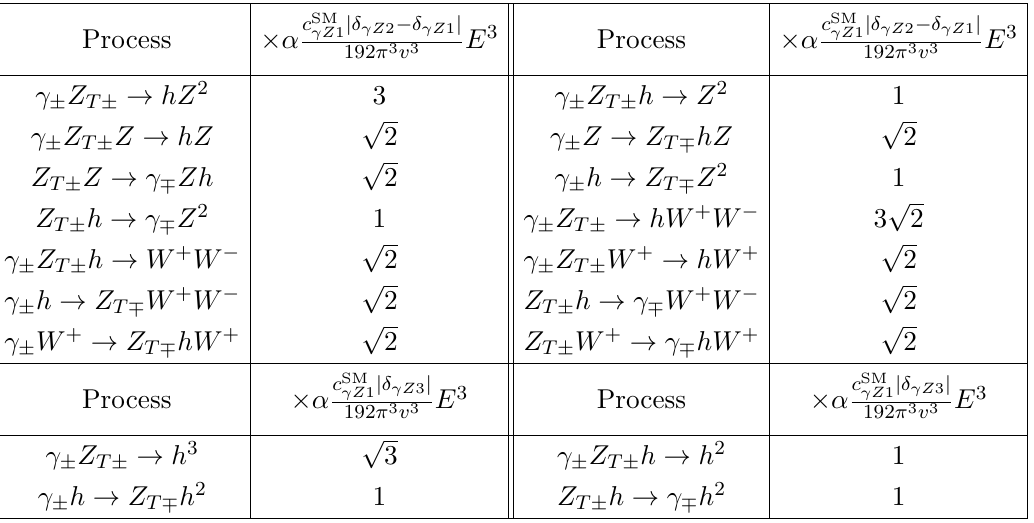
Table 6 . | ˆ M | of the 5-body unitarity-violating processes arising from the modification of the Higgs coupling to γZ